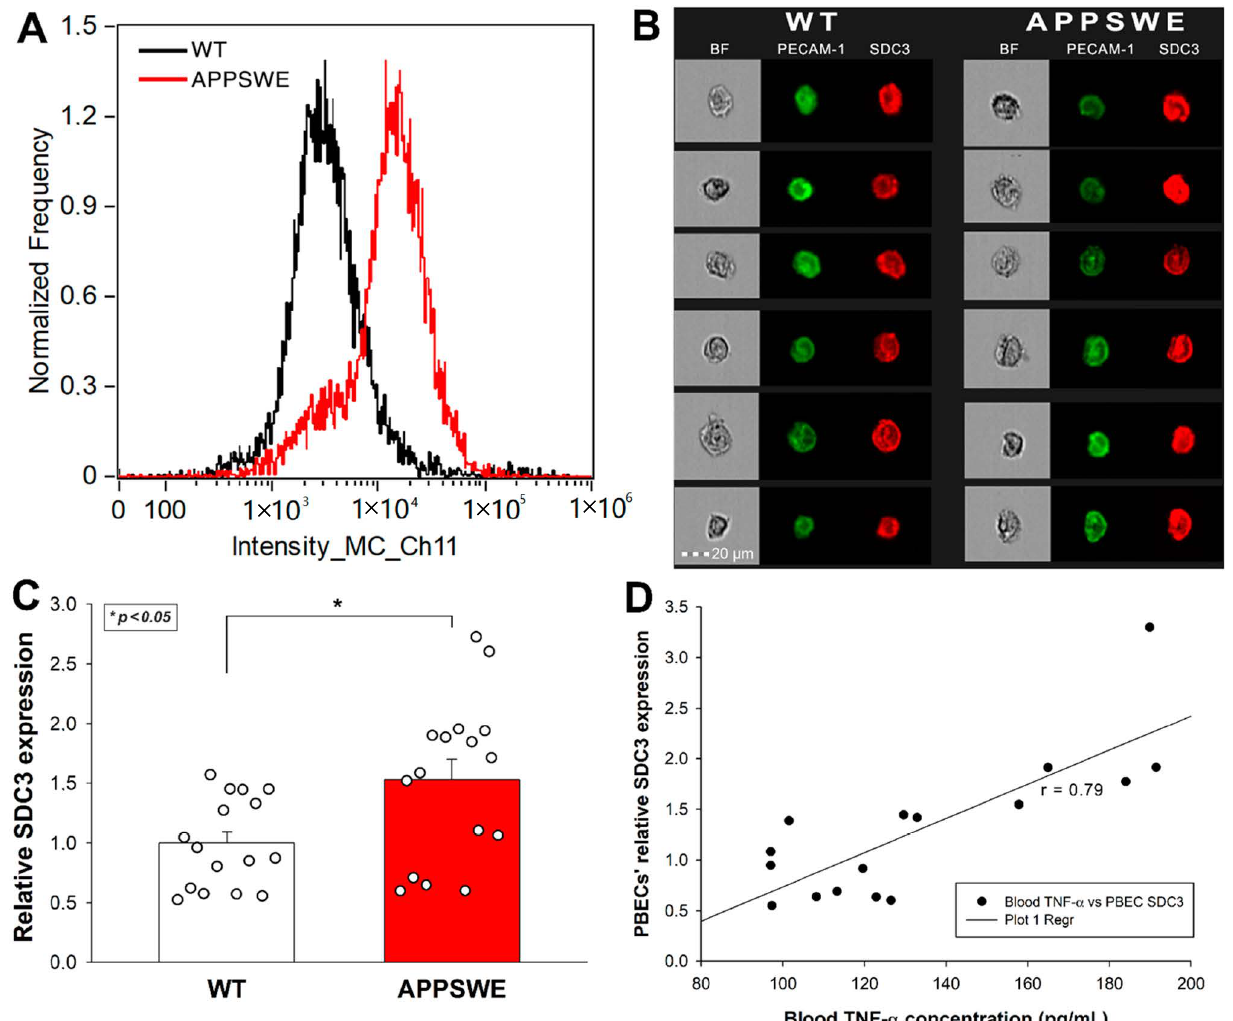
Figure 5. PBECs of APPSWE-Tau mice exhibits increased SDC3 expression. Isolated PBECs were treated with PECAM-1 and SDC3 antibodies, and SDC3 expression of PECAM-1 positive cells was analyzed with imaging flow cytometry. ( A ) Representative histogram showing the SDC3 expression of PBECs isolated from APPSWE-Tau and WT mice. ( B ) BF and fluorescent cellular images of PECAM-1 and SDC3 antibody-treated PBECs, isolated from APPSWE-Tau and WT mice. Each group contained eight animals. SDC3 expression of each sample was measured twice. ( C ) Detected fluorescence intensities were normalized to WT. The bars represent the mean + SEM. Statistical significance vs. WT was assessed with ANOVA. * p < 0.05. ( D ) Linear regression between in PBECs’ relative SDC3 expression and blood TNF- α concentrations.